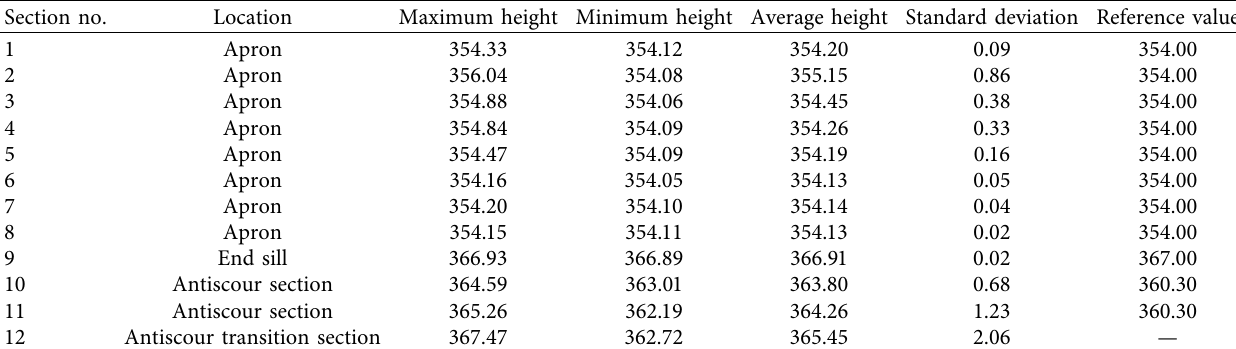
Table 3: Comparison table of elevation parameters among selected sections of the bottom outlet stilling basin (unit: m). Section no.